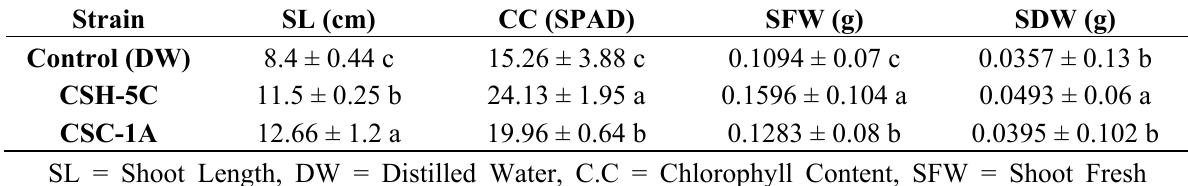
Table 2. Effect of culture filtrate of isolated endophytic fungal strains on the growth of Dongjin-beyo